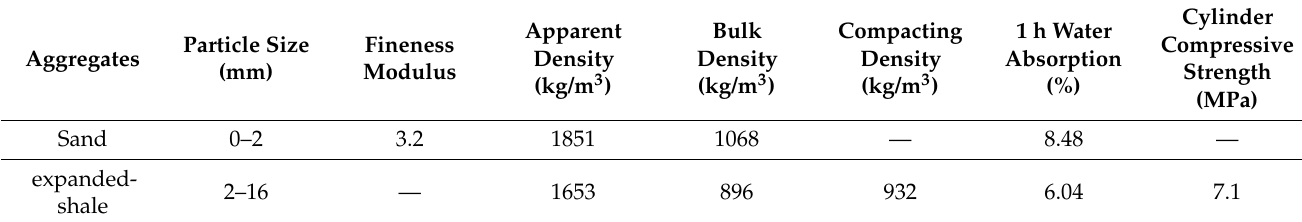
Table 4. Physical and mechanical properties of expanded-shale and ceramsite